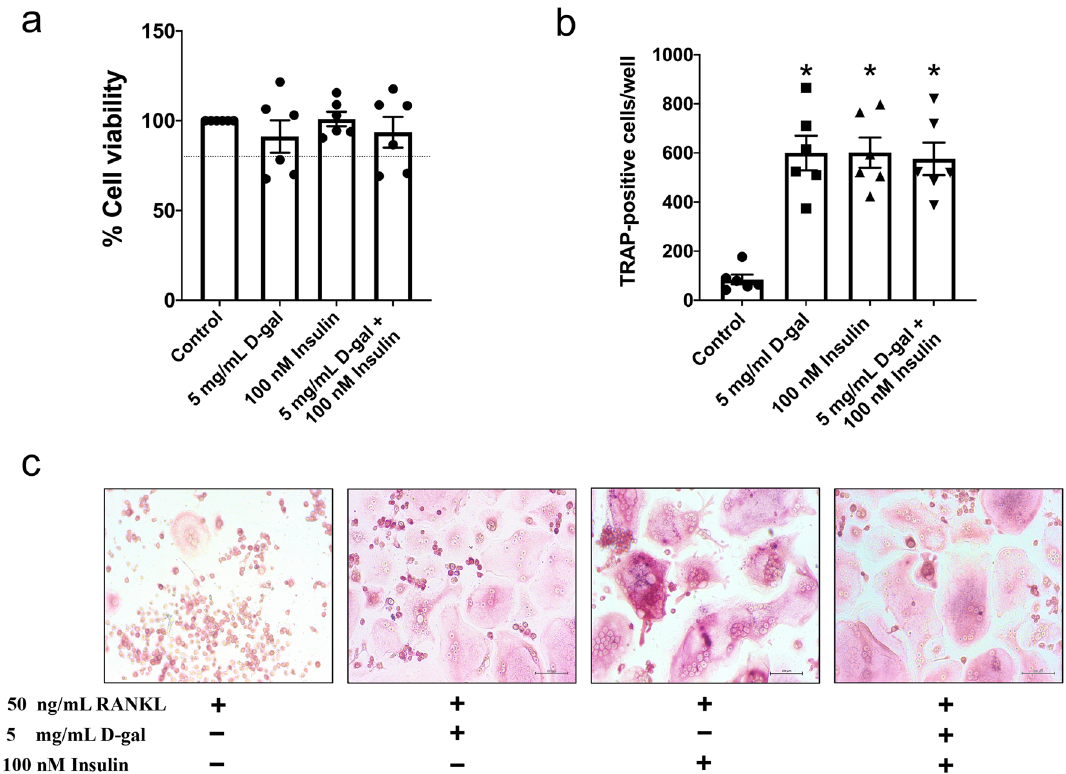
Figure 5. D-galactose-induced senescence and hyperinsulinism-stimulated insulin resistance accelerated RANKL-induced osteoclast differentiation in RAW 264.7 cells. ( a ) % cell viability of RAW 264.7 belonging to four treatment group, ( b ) Number of TRAP-positive multinucleated cells which presented more than three nuclei indicated a mature osteoclast. ( c ) TRAP positive staining of RANKL-stimulated multinucleated osteoclasts with the treatments of control, 5 mg/mL D-galactose, 100 nM insulin and the combined treatment (20 × magnification). Bar graphs presented as mean ± SEM (n = 6/group).* p < 0.05 versus control group. D-gal, D-galactose; RANKL, receptor activator of nuclear factor κB ligand; TRAP, tartrate-resistant acid